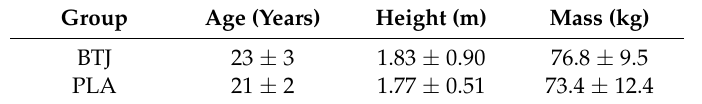
Table 1. Descriptive data for participants in the beetroot juice (BTJ) and placebo (PLA) groups.